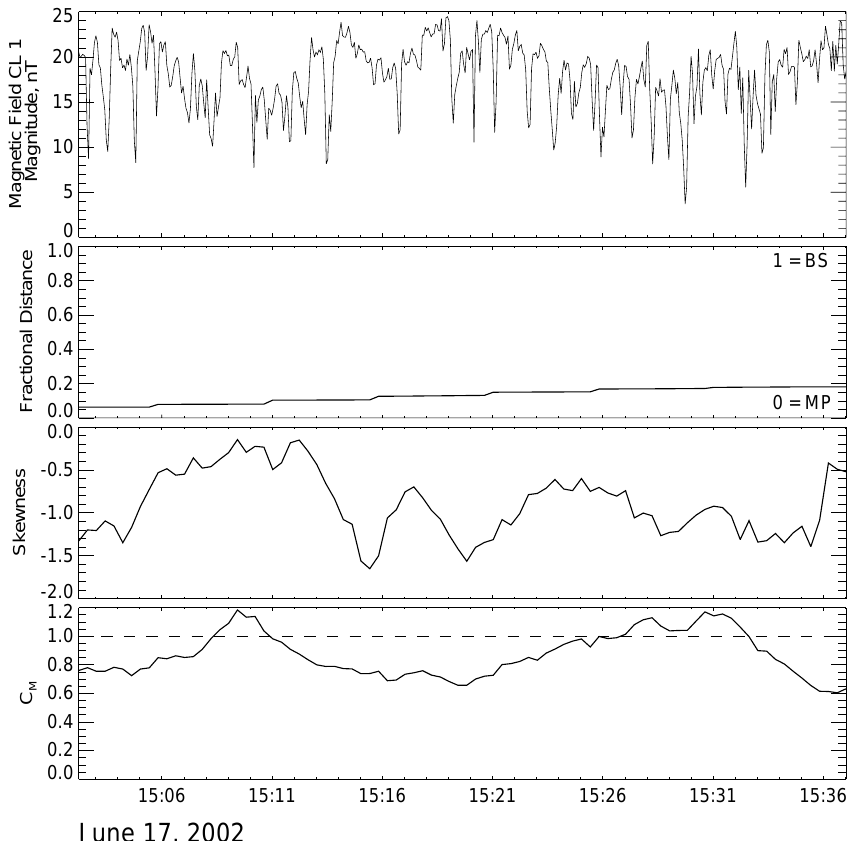
Fig. 6. Observations of magnetic holes by Cluster 1 on 17 June 2002 (same panels as in Fig. 1).